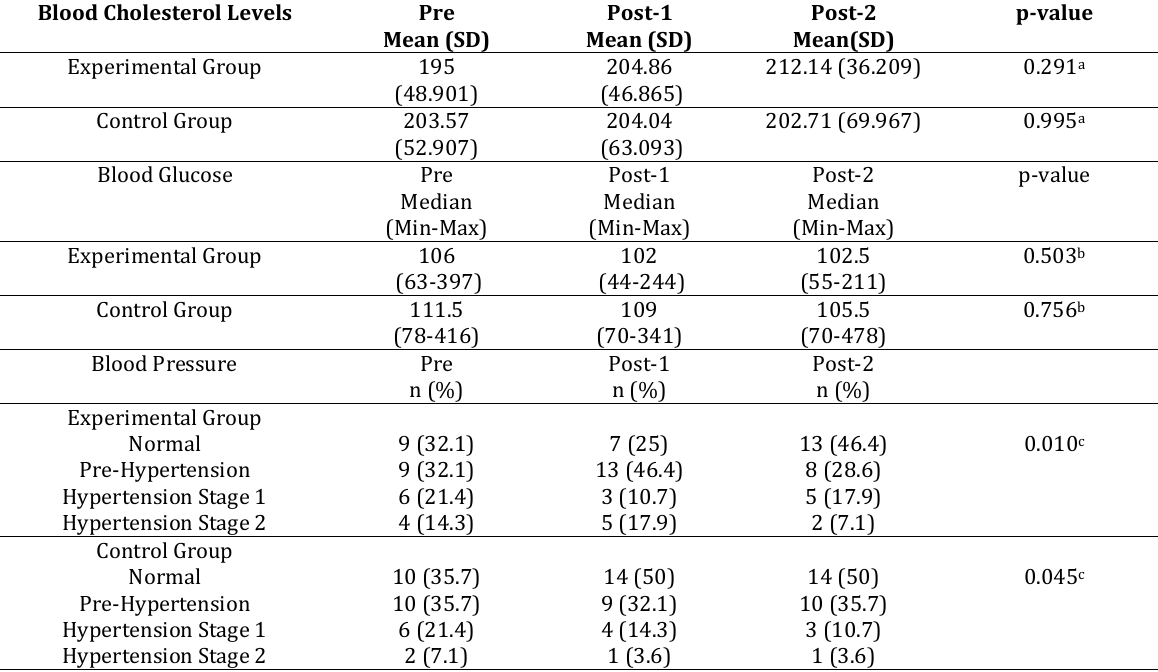
Table 6. Results of blood cholesterol level, blood glucose and blood pressure in the experimental and control group Blood Cholesterol Levels